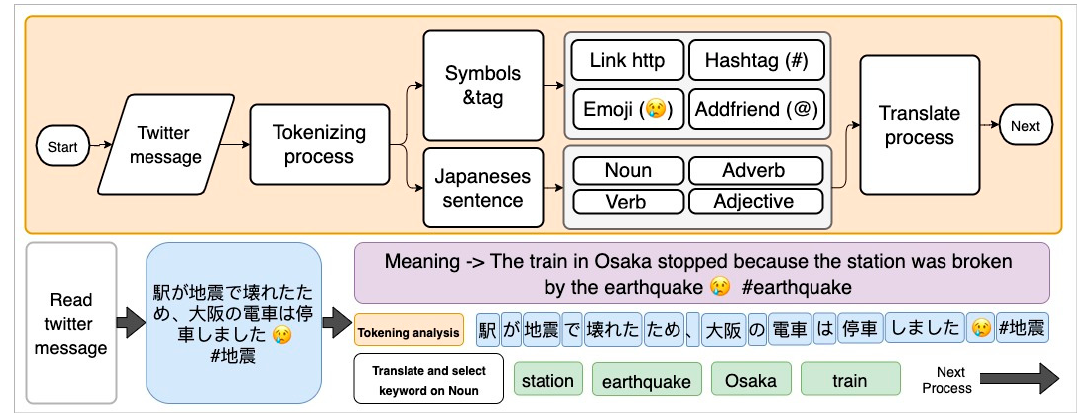
Figure 4. Tweets tokenizing and analysis process.